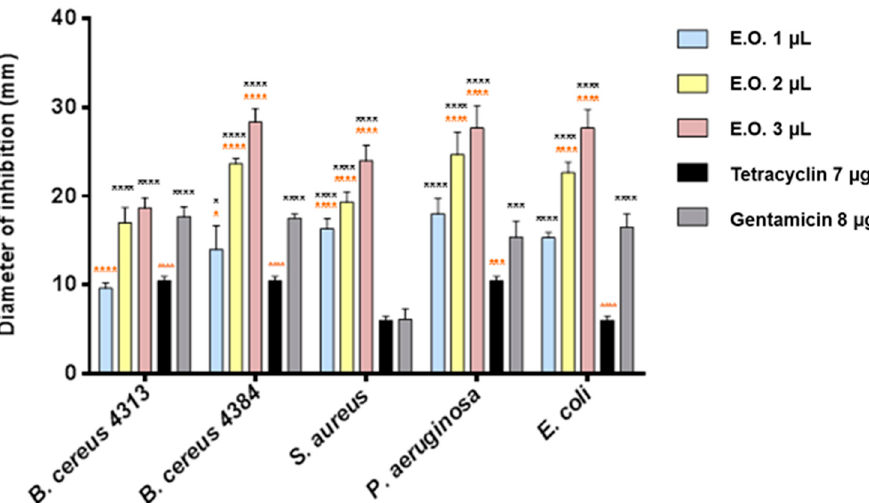
Figure 2. Antibacterial activity of EO of Citrus medica cv. ‘rugosa’ and of the reference compounds, gentamicin and tetracycline. Results are the mean of three experiments. Dunnett’s test vs. gentamicin 8 μ g: **** p < 0.0001; *** p < 0.001; * p < 0.05; Dunnett’s test vs. tetracycline 7 μ g: **** p < 0.0001; *** p < 0.001; * p < 0.05. Table 2. Minimal inhibitory concentration (MIC, μ L) of the EOs of Citrus medica cv. ‘liscia’ and cv. ‘rugosa’ and of their main components, limonene and camphene.